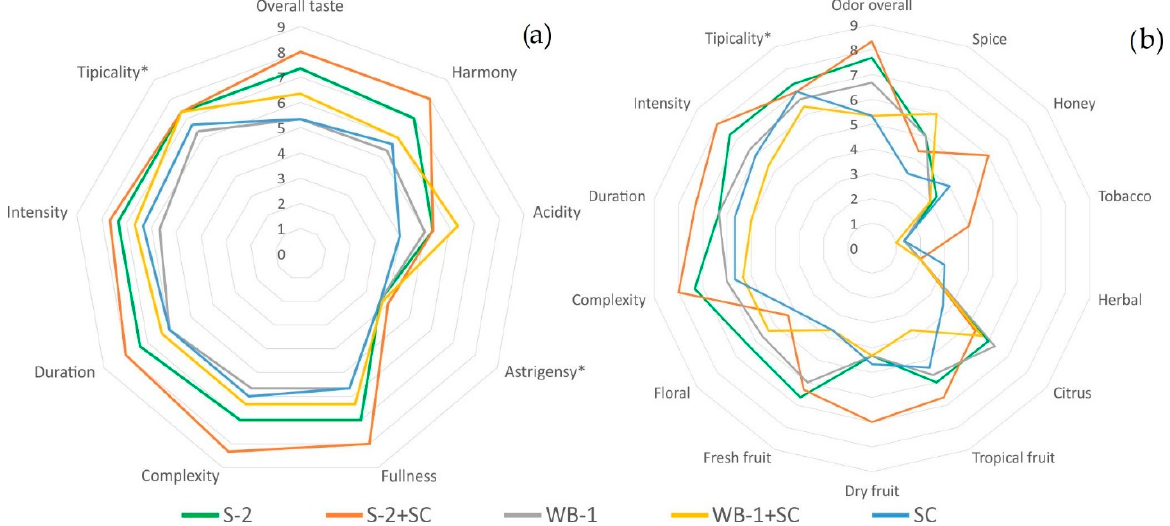
Figure 2. Gustatory ( a ) and olfactory ( b ) attribute scores for Tamjanika wine samples produced in pure and sequential fermentations inoculated with a two non- Saccharomyces strains ( C. famata WB-1 and H. uvarum S-2) and S. cerevisiae QA23 (SC). Data were the mean of two biological replicates of fermentation. Asterisks indicate that there is no significant differences between the means in attribute intensities ( p < 0.05, Tukey’s HSD test).